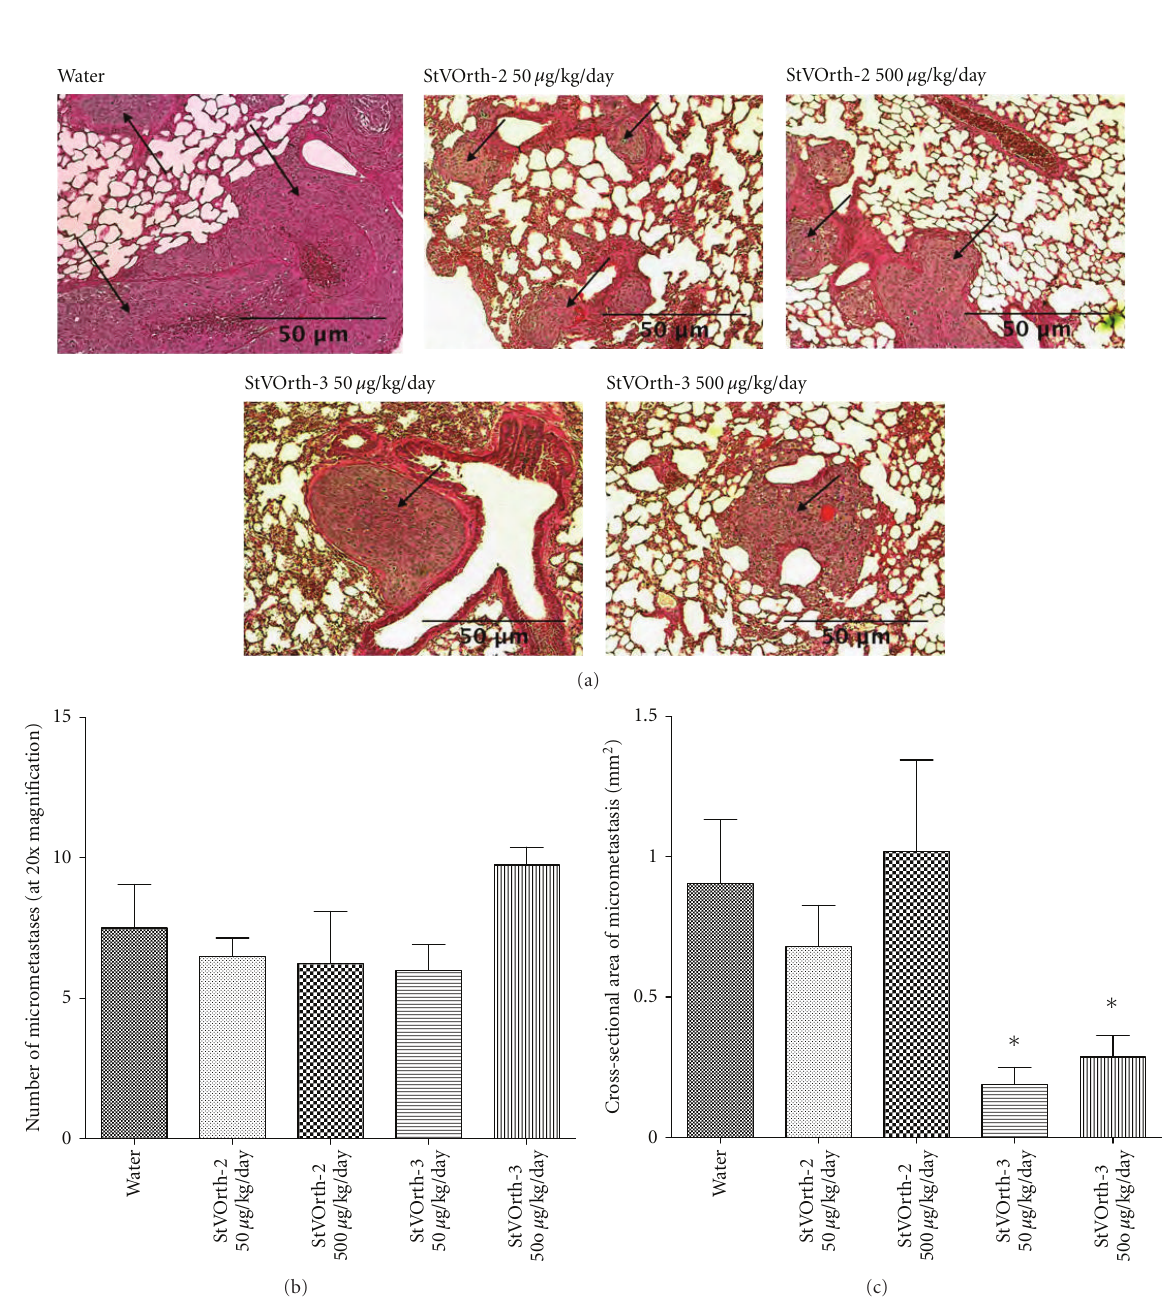
Figure 5: Systemically delivered StVOrth-3 inhibits progression of pulmonary metastatic disease. (a) Haematoxylin- and eosin-stained sections of lung tissue show micrometastases (arrows) disrupting the native alveolar architecture. Metastatic lesions were predominately subpleural and around larger airways. (b) Number of pulmonary micrometastases per lung section at 20x magnification ( ± SEM). (c) Cross- sectional areas of pulmonary micrometastases ( ± SEM). ∗ P < 0 . 05, one-way